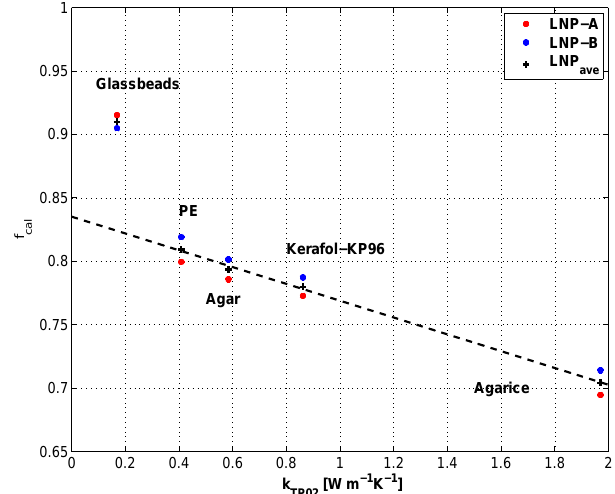
Fig. 5. Calibration of the custom-made LNP-sensors versus the Fig.5. Calibrationofthecustom-madeLNP-sensorsversusthecommercialHuksefluxTP02thermalconductivitysensor,whichisconsidered asthereferencesensor. ThesymbolsrepresenttheaveragemeasurementvaluesobtainedfromthetwoLNPprobes,whilethedottedlineis commercial Hukseflux TP02 thermal conductivity sensor, which is alinearfitbetweenthemeasurementvaluesusingthedatafrombothLNP-sensors. considered as the reference sensor. The symbols represent the aver- age measurement values obtained from the two LNP probes, while the dotted line is a linear fit between the measurement values using the data from both LNP-sensors.